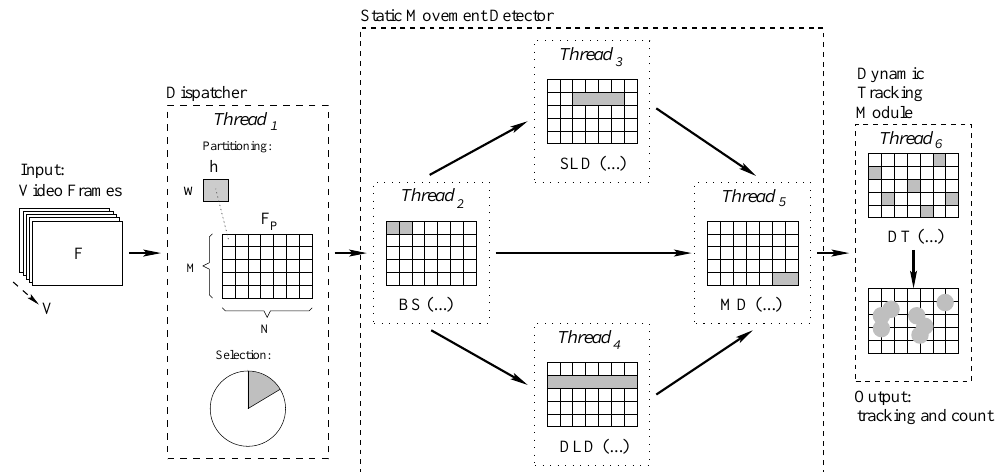
Figure 1. Overall information flow of our algorithm (from left to right): (1) The input video frame F ; (2) The dispatcher, i.e., a divide-and-conquer partitioning module; (3) The static movement detector (running in parallel sub-modules). BS: background subtraction; SLD: static luminosity detector; DLD dynamic luminosity detector; MD: movement detector. (4) The dynamic tracking (DT)